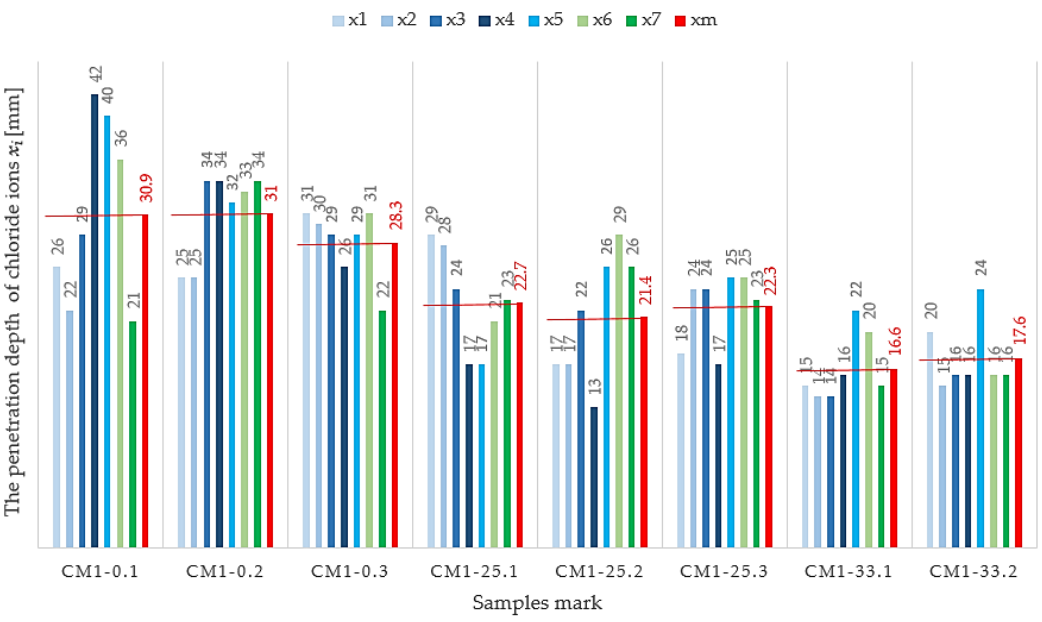
Figure 2. The penetration depth of chloride ions in the tested concrete samples.